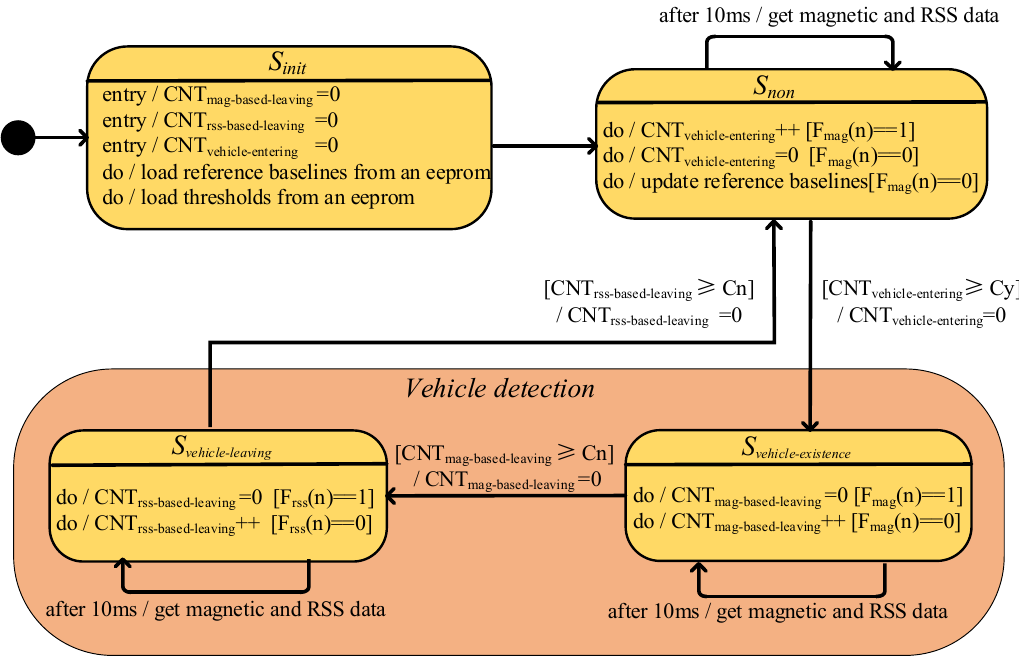
Figure 5. The state machine of the two-sensors data fusion vehicle detection method.